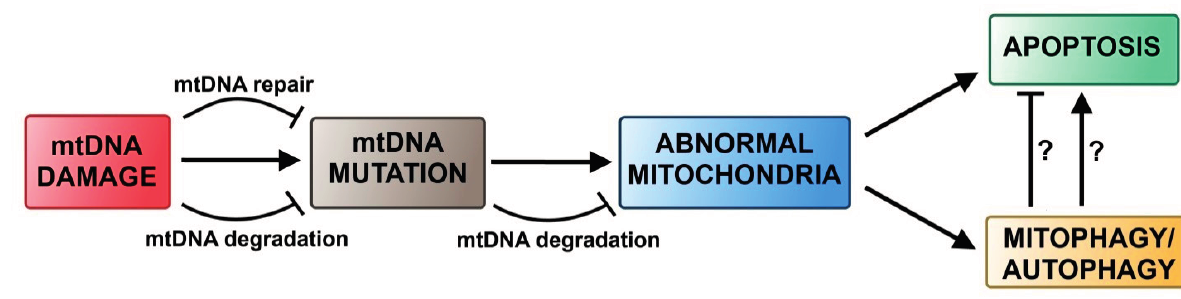
Figure 4. Autophagy in mitochondrial DNA damage response. Damaged